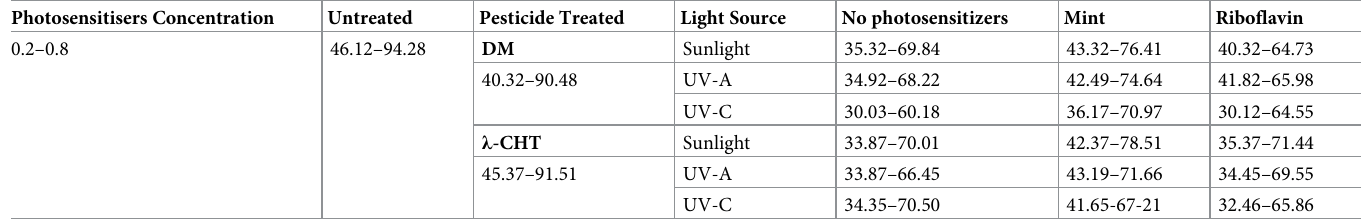
Table 2. Effect of light and green chemicals on the percent DPPH radical scavaging activity (range %inhibition) of cauliflower extracts (concentration of extract here) with and without pesticides application. Photosensitisers